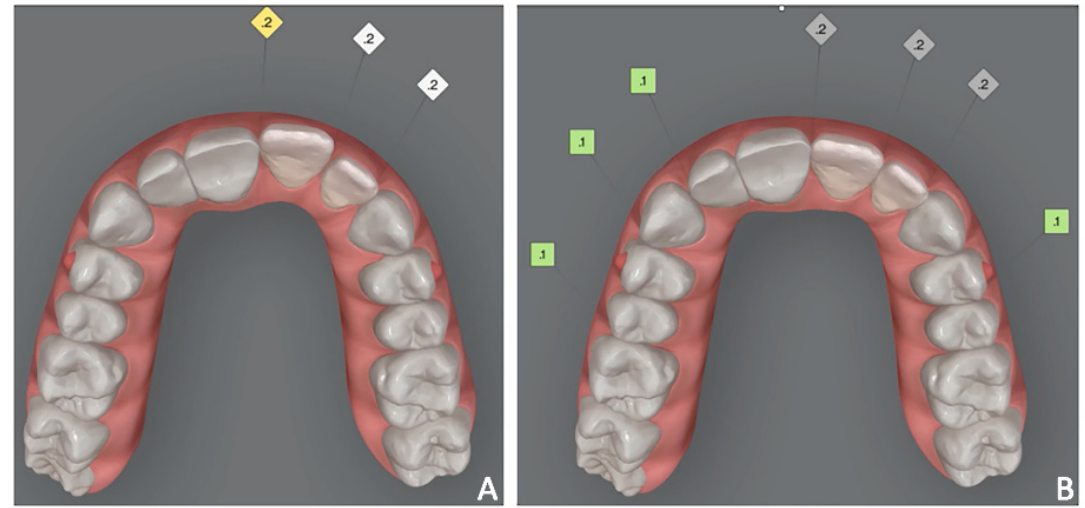
Figure 12. Case 2. Orthodontic set-up. ( A ) pre-treatment; ( B ) simulated final position of 2.1 and 2.2 using the position of 1.1 and 1.2 as references.